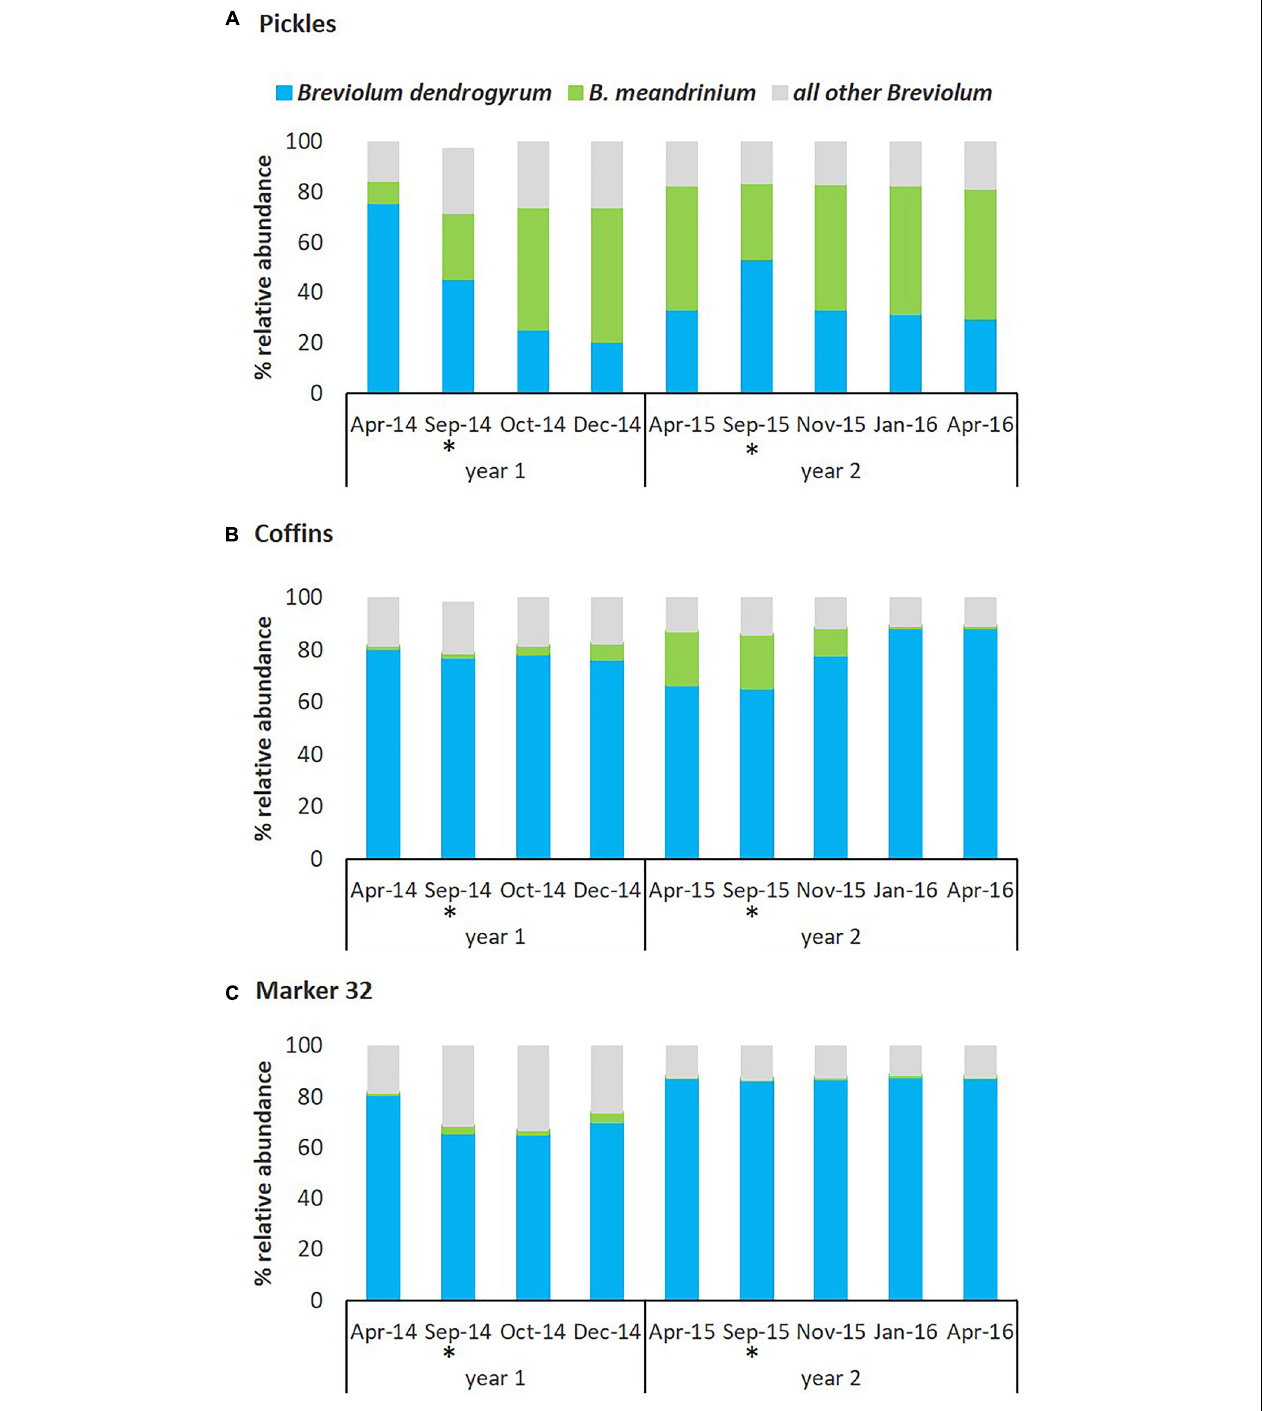
FIGURE 6 | Relative abundance of Symbiodiniaceae symbionts from the genus Breviolum associated with D. cylindrus on the Florida Reef Tract between 2014 and 2016. The dynamics of Breviolum dendrogyrum (blue) and B. meandrinium (green) between three sites and between years, by percent relative abundance of Breviolum spp. OTUs. B. meandrinium increased in relative abundance during bleaching and recovery, becoming the dominant symbiont species at the Pickles site in 2014 and 2015. (A) Pickles ( n = 6) Upper Keys, (B) Coffins ( n = 6) Middle Keys, (C) Marker 32 ( n = 6) Lower Keys. ‘All other Breviolum ’ (blue-gray) represents 250 OTUs combined. Asterisk ( ∗ ) indicates bleaching